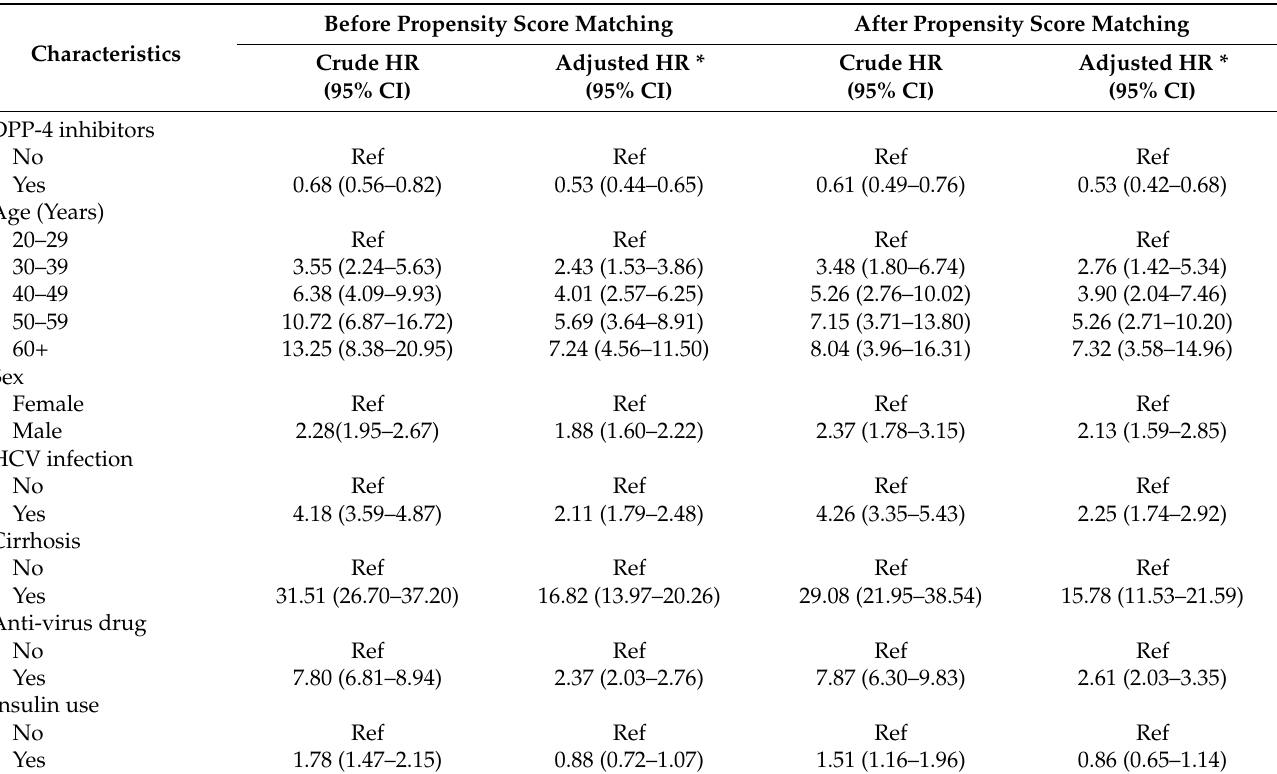
Table 3. DPP4 inhibitors use associated with decreased risk for hepatocellular